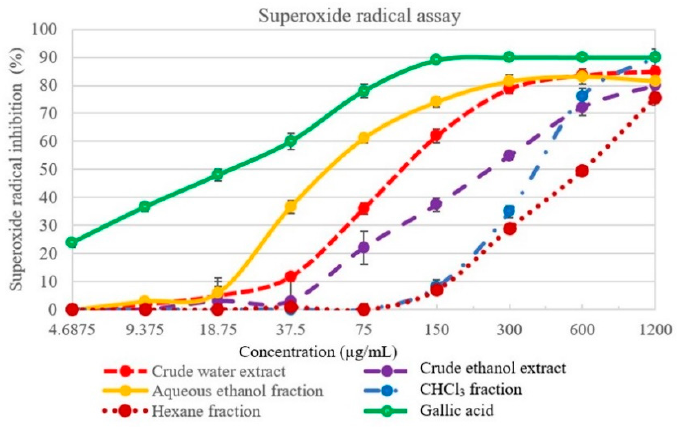
Figure 6. Effect of L. martabanica fractions on superoxide radical scavenging. Values are expressed as mean ± S.E.M. from three independent experiments. Table 2. The IC 50 values of L. martabanica root extracts in DPPH assay and superoxide radical assay. Test